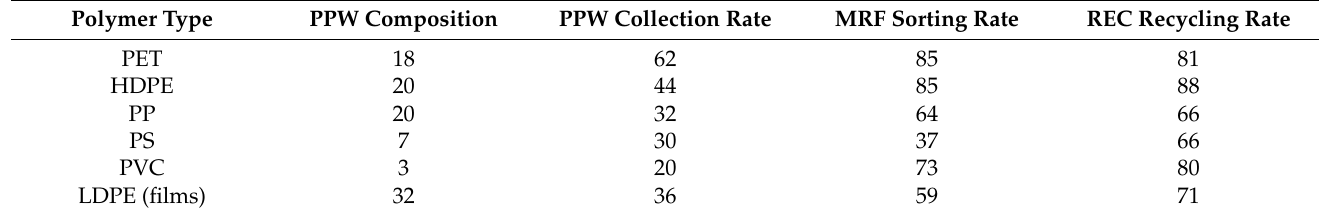
Table 3. Composition of PPW and performance at the different stages of the recycling system. Values are medians and expressed in percentage. Data are taken from [62,63] (PPW collection rate).